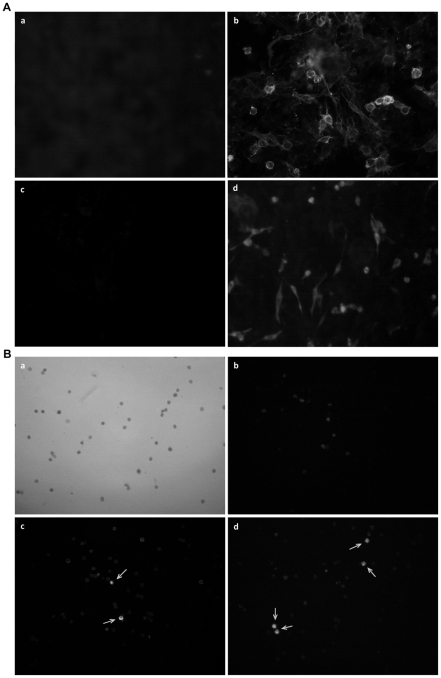
Detection of wPD-L1 and wPD-L2 by specific antisera.BHK cells were transiently transfected with pCI-wL1. or pxf3H-wL2 plasmids. Transfected cells were fixed for IF staining after 48 h. (A) Untransfected cells stained by anti-wPD-L1 (a) or anti-wPD-L2 (c), cells transfected with pCI-wL1 and stained with rabbit anti-wPD-L1 antiserum (b), cells transfected with pxf3H-wL2 and stained with rabbit anti-wPD-L2 antiserum (d). (B) Woodchuck PBMCs in phase contrast (a) and IF staining of woodchuck PBMCs with control antibody (b), anti-wPD-L1 (c), or anti-wPD-L2 (d) antibody. The positively stained cells are indicated by arrows.